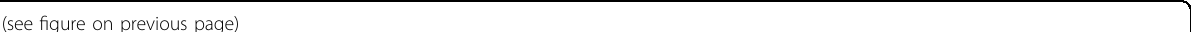
Fig. 5 Memory phenotype differentiation of speci fi c memory T cells. a Overlay fl ow cytometry plots in the I-I- δ , I-I- ο , M-M- ο , and I-I-I groups showing S/M/N/E- and RBD-speci fi c memory CD4 + and CD8 + T-cell phenotypes in ex vivo assay. b , c Frequency of different RBD-speci fi c CD4 + and CD8 + memory T cells in the I-I- δ ( n = 25), I-I- ο ( n = 21), M-M- ο ( n = 9), and I-I-I ( n = 40) groups. d Overlay fl ow cytometry plots showing RBD-speci fi c memory CD4 + and CD8 + T-cell phenotypes in in vitro assay. e , f Frequency of different RBD-speci fi c CD4 + and CD8 + memory T cells in the I-I- δ , I-I- ο , M-M- ο , and I-I-I groups. Data in bar charts are shown as the means ± SEM and those in dot plots as the mean. Each dot represents one donor. Comparisons were performed using Mann – Whitney tests. * P < 0.05, ** P < 0.01, *** P <